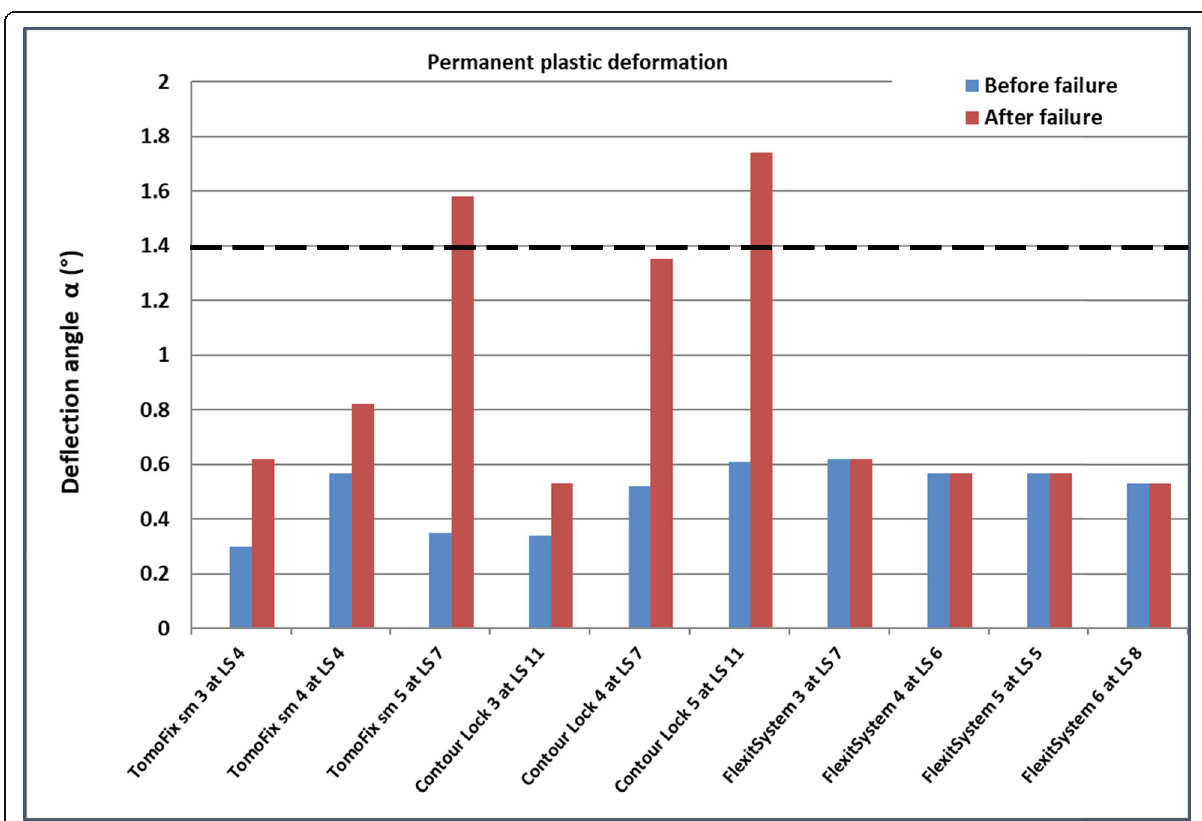
Fig. 7 Deflection angle or valgus-malrotation of the tibia head before and after the failure for groups IV, V (From our previous studies) and VII. The same values were considered before and after the failure for group 7. A type 1 failure was observed for the specimens TomoFix sm 5 and Contour Lock